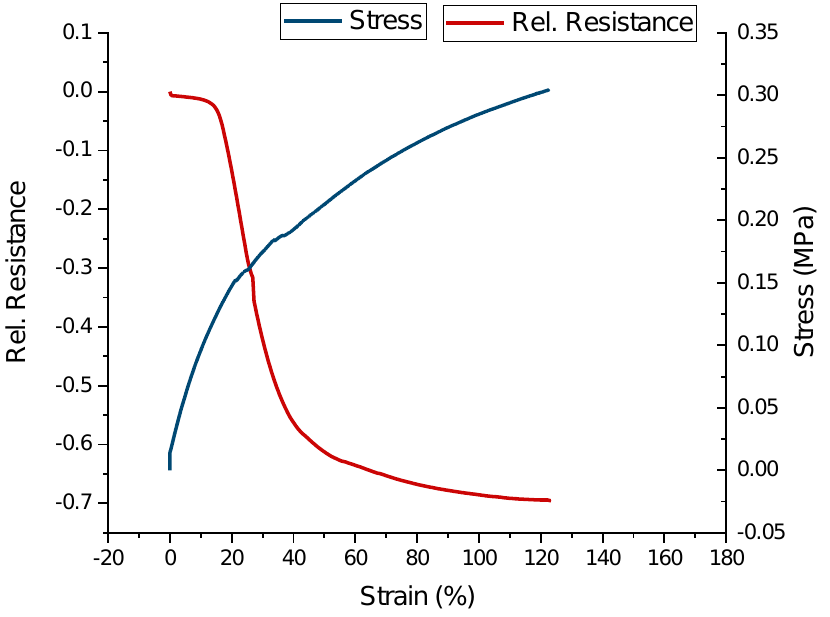
Figure 7. Mechanical behavior and the response of the electrical resistance during a tensile test to the point of fracture for the ShSFC.